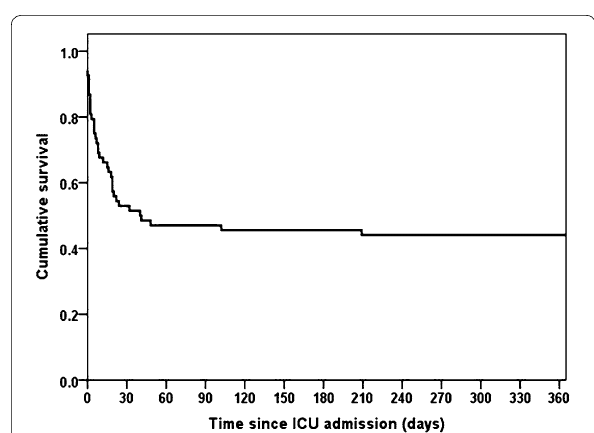
Fig. 2 Kaplan–Meier survival curve of 68 patients with cirrhosis admitted to a general ICU